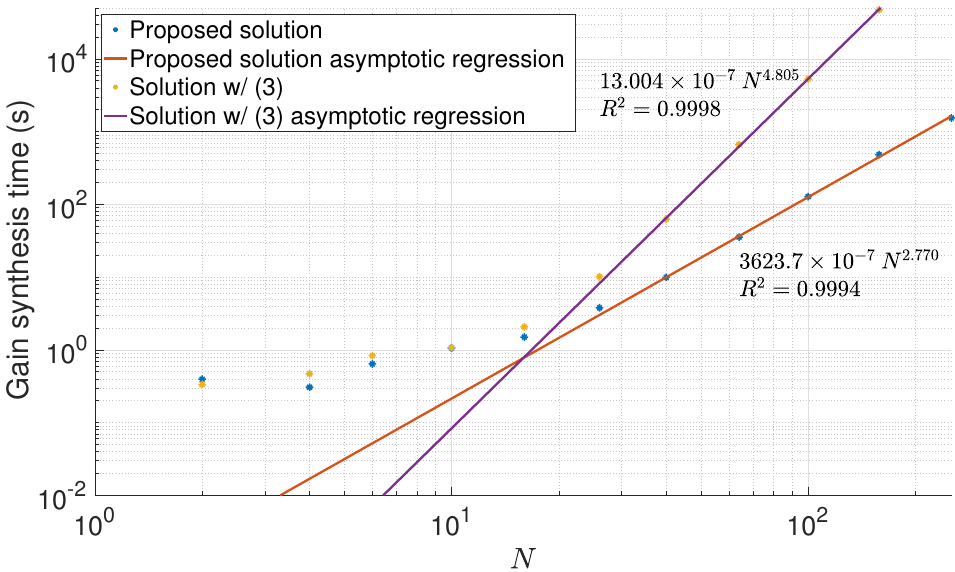
Figure 2. Synthesis wall-clock time of a distributed filter for the N tanks network, as a function of the dimension of the